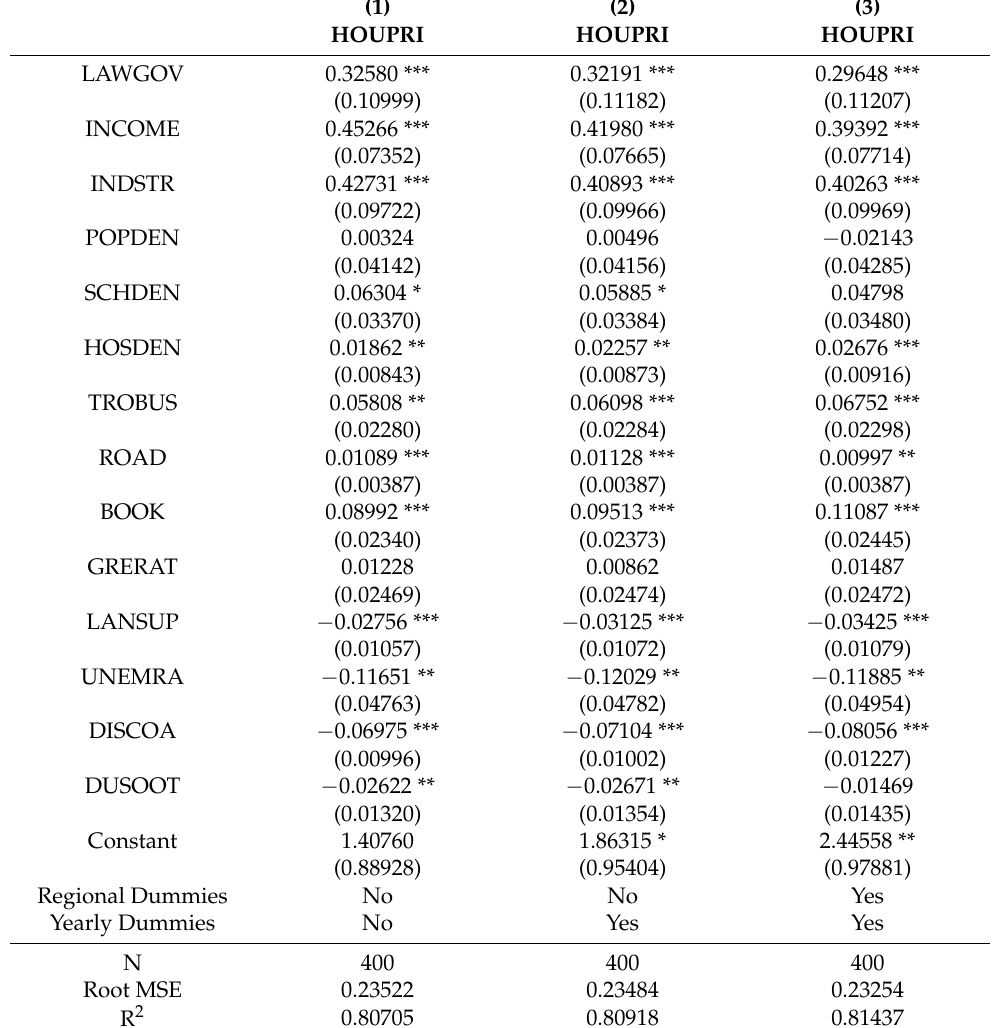
Table 3. Baseline